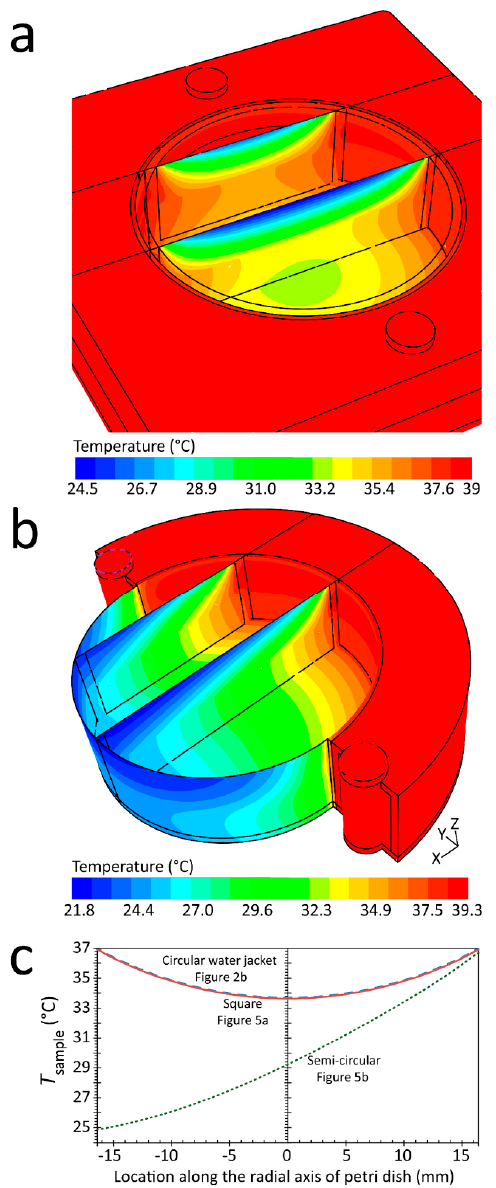
Figure 5. Numerical simulations indicating the change of temperature distribution across the Petri dish by varying the geometry of the water jacket. ( a ) A square water jacket led to symmetrical temperature contours similar to those of a circular water jacket. ( b ) A semi-circular water jacket led to asymmetrical temperature contours due to formation of cold and hot regions across the Petri dish. ( c ) Comparison of temperature profiles along the radial axis of circular (reference), square and semi-circular water jackets revealing temperature gradients of 3.28, 3.29, and 12 ◦ C, respectively. The flow streamlines associated with the square and semi-circular water jackets are presented in Figures